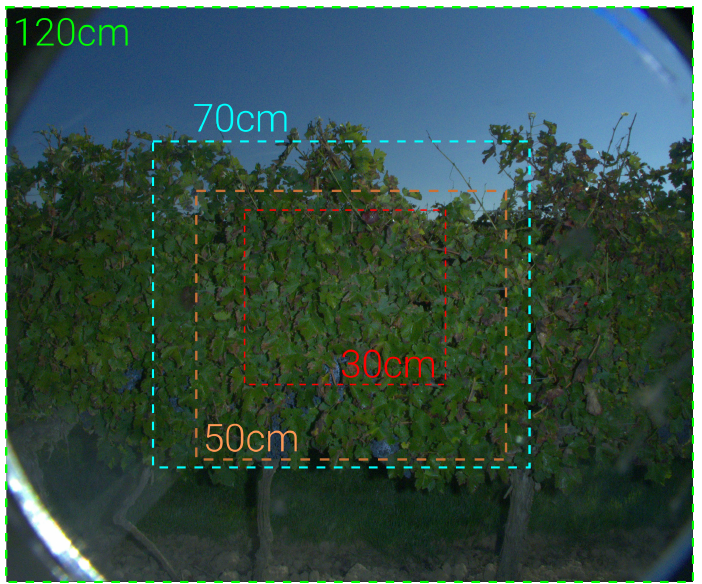
Figure 6. Examples of framing possibilities on one vine row. For each framing example (color dotted rectangles), the corresponding distance between the camera and the vertical trellis is indicated with the same